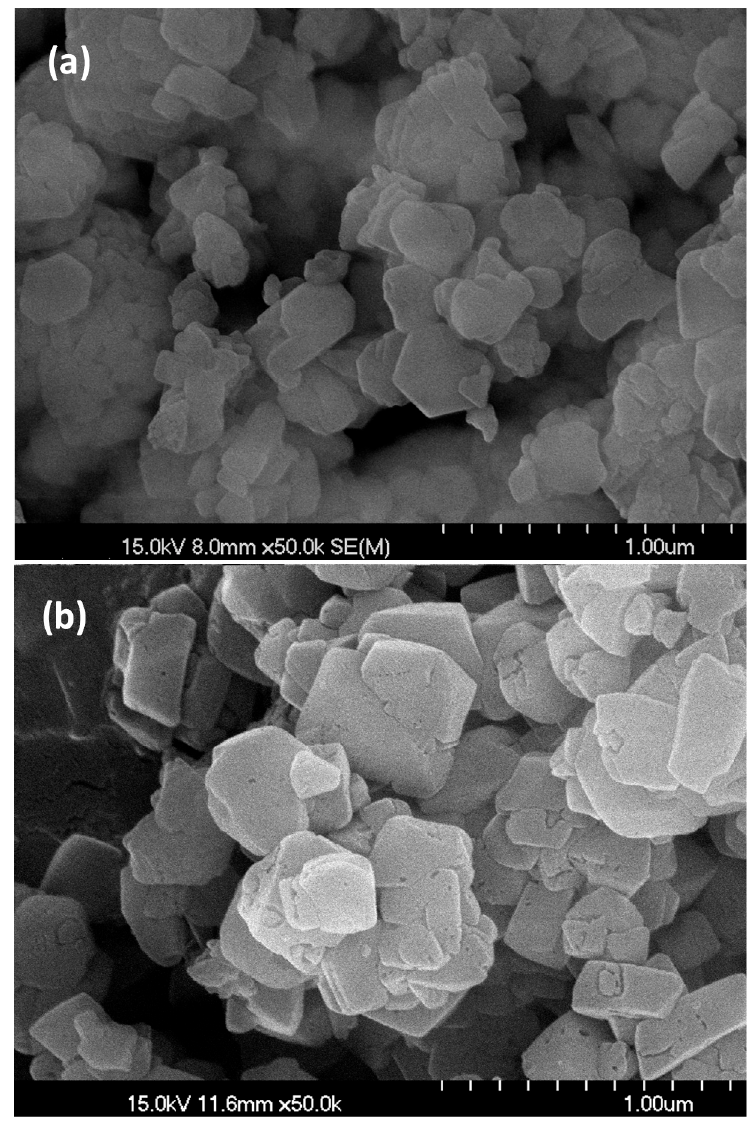
Figure 2. Scanning electron microscopy (SEM) images of ( a ) HZ(25) and ( b ) HY(3) zeolites.